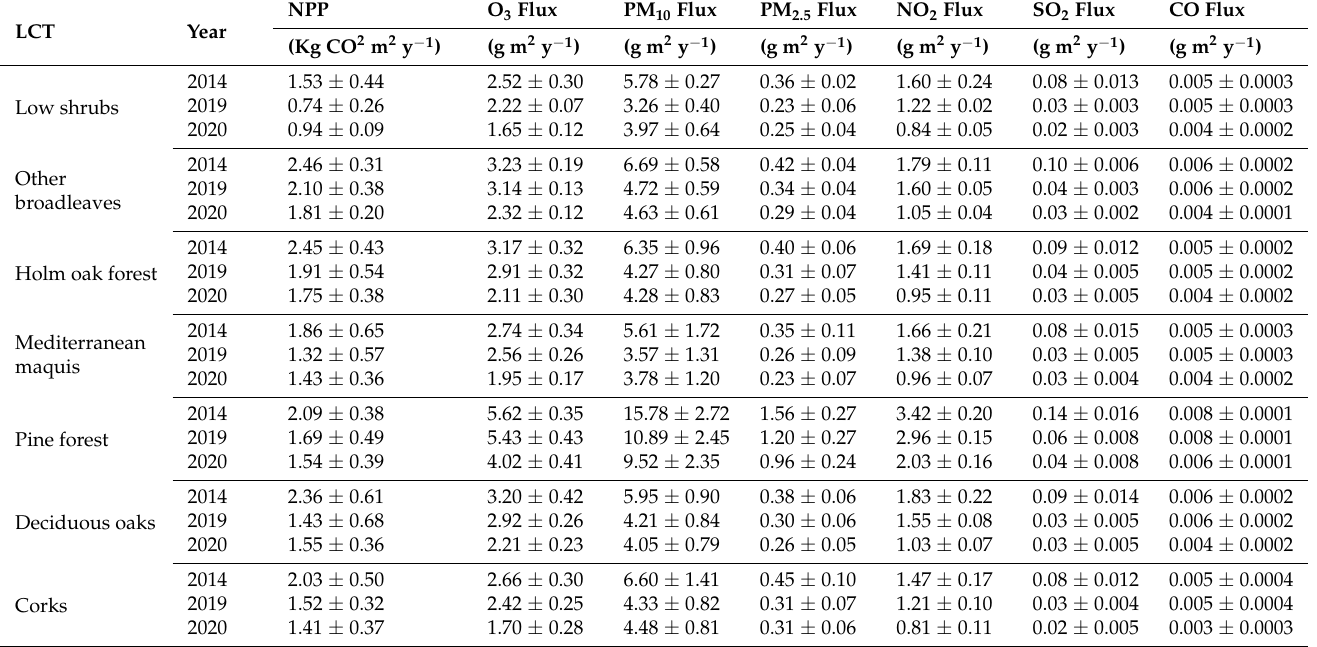
Table 1. Mean annual estimate and standard deviation of Carbon uptake (NPP), Ozone (O 3 flux), Particulate matter fluxes (PM 10 and PM 2.5 ), fluxes of Nitrogen dioxide (NO 2 ), Sulphur dioxide (SO 2 ) and Carbon monoxide (CO) for the three years of study (2014, 2019 and 2020), for each LCT are